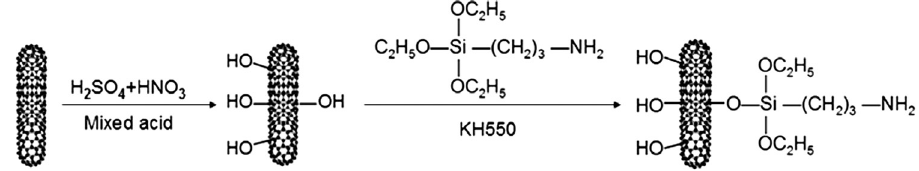
Figure 3 Mechanism of CNT surface modification.